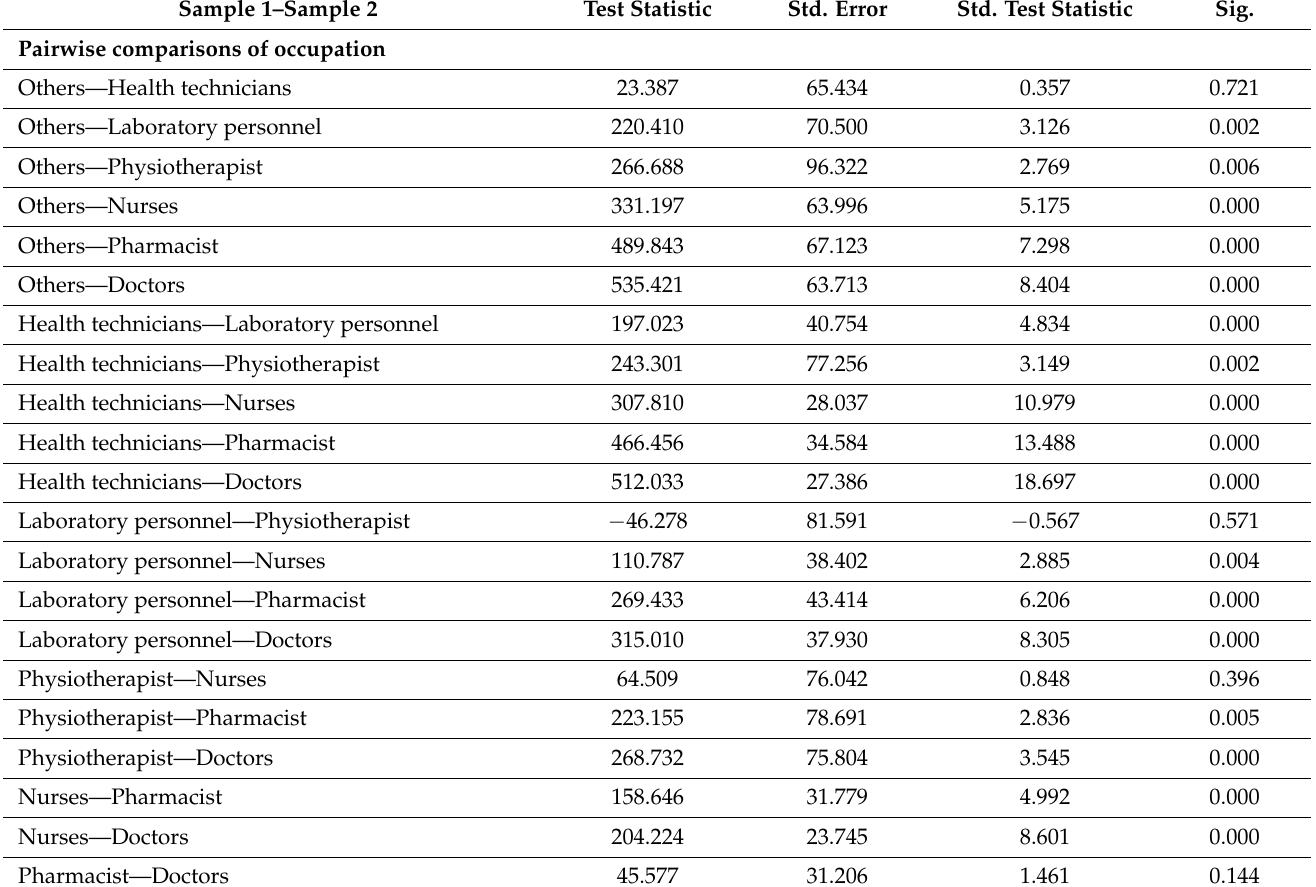
Table 3. Pairwise comparisons of knowledge scores in occupation and education